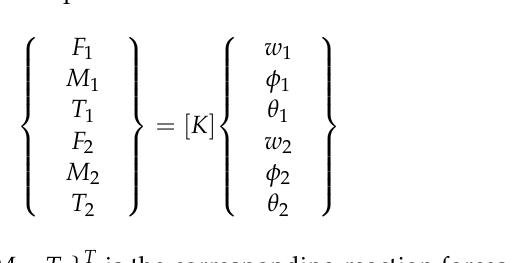
in which { F 1 M 1 T 1 F 2 M 2 T 2 } T is the corresponding reaction forces and